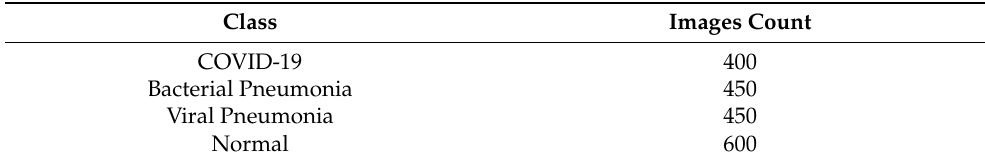
Table 2. Dataset summary of classification for